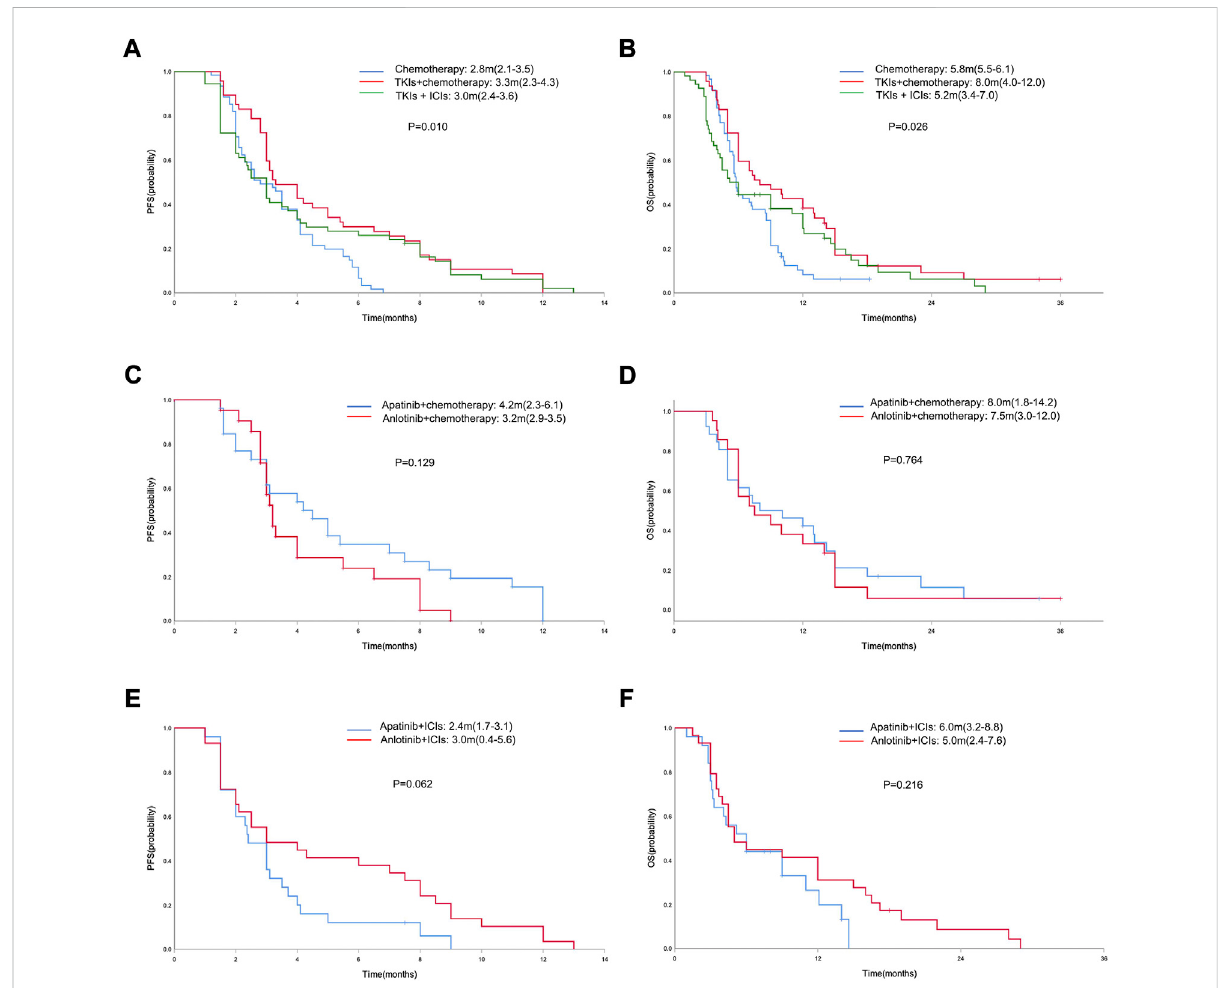
FIGURE 3 Kaplan-MeiercurveofPFS (A) and OS (B) inthechemotherapy,TKIs + chemotherapy and TKIs+ ICIs population. Kaplan-Meier curveof PFS (C) and OS (D) inthe TKIs + chemotherapy group with respect to treatment type (apatinib plus chemotherapyvs. anlotinib pluschemotherapy). Kaplan- Meier curve of PFS (E) and OS (F) in the TKIs + ICIs group with respect to treatment type (apatinib plus ICIs vs. anlotinib plus